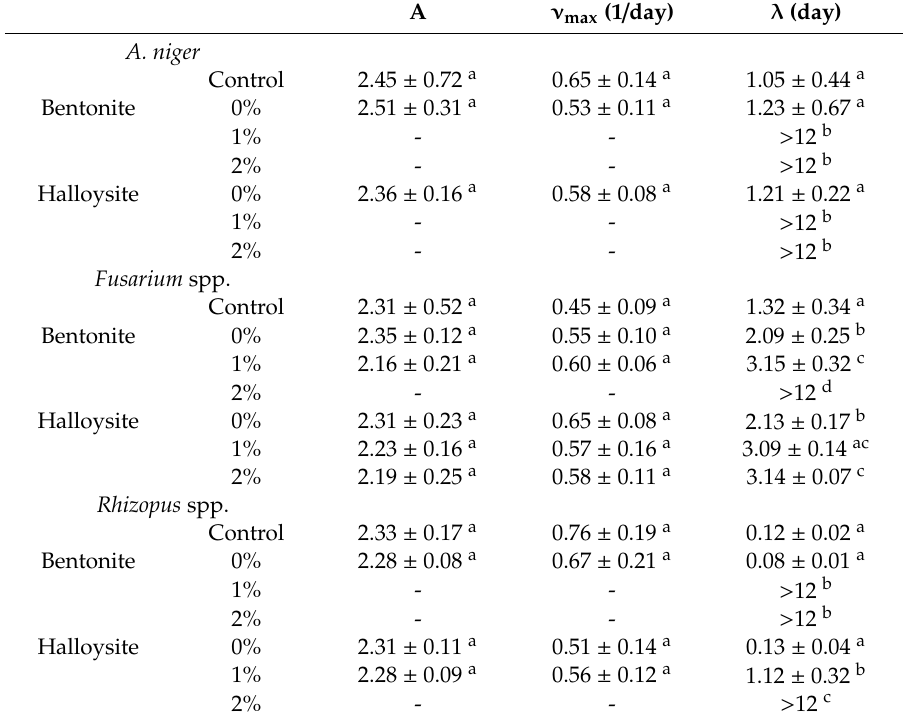
Table 2. Modified Gompertz model parameters + (mean ± standard deviation) for A. niger , Fusarium spp., and Rhizopus spp. growth curves of starch edible films added with selected concentrations of Mexican oregano ( Lippia berlandieri Schauer) essential oil and nanocomposites (bentonite or halloysite). Mean values for each microorganism in the same column not sharing a common superscript are significantly di ff erent ( p <